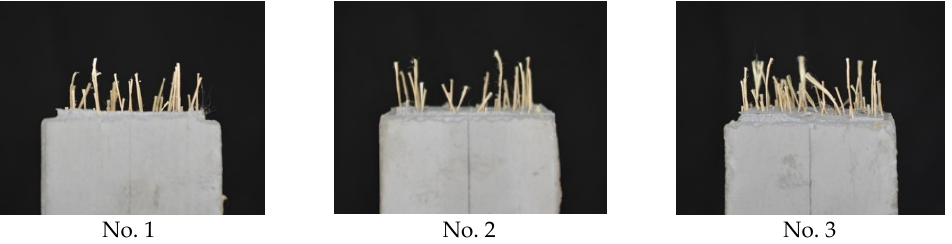
Figure 15. Uniaxial tension test specimen: ( a ) Dimensions of cross-section; ( b ) Specimen at loading.